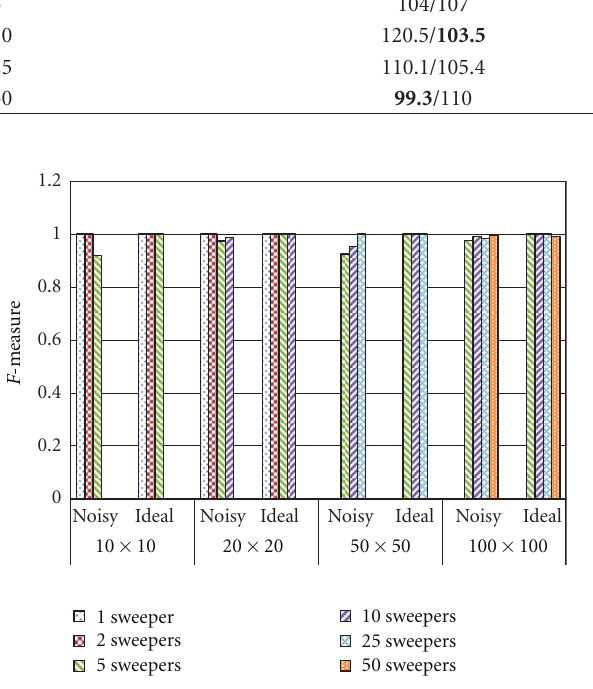
Figure 13: F -measure in noisy versus ideal sensor model.